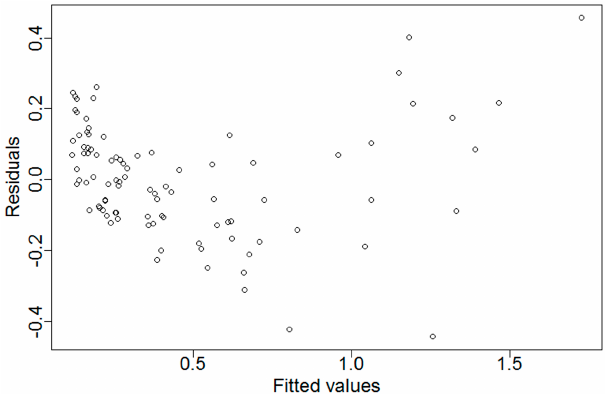
Figure 5. Plot of the residuals of Model 1 versus fitted values. Note the spread increase of the residual values with the increase of the fitted values.